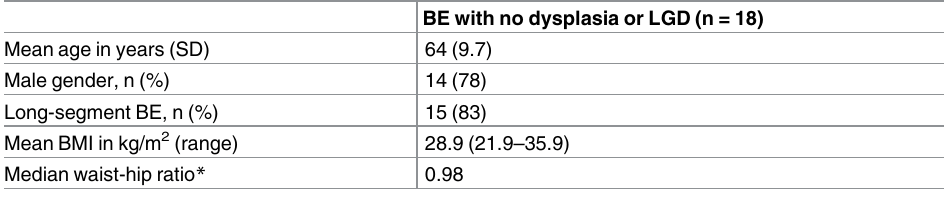
Table 1. Baseline characteristics of participants completing the